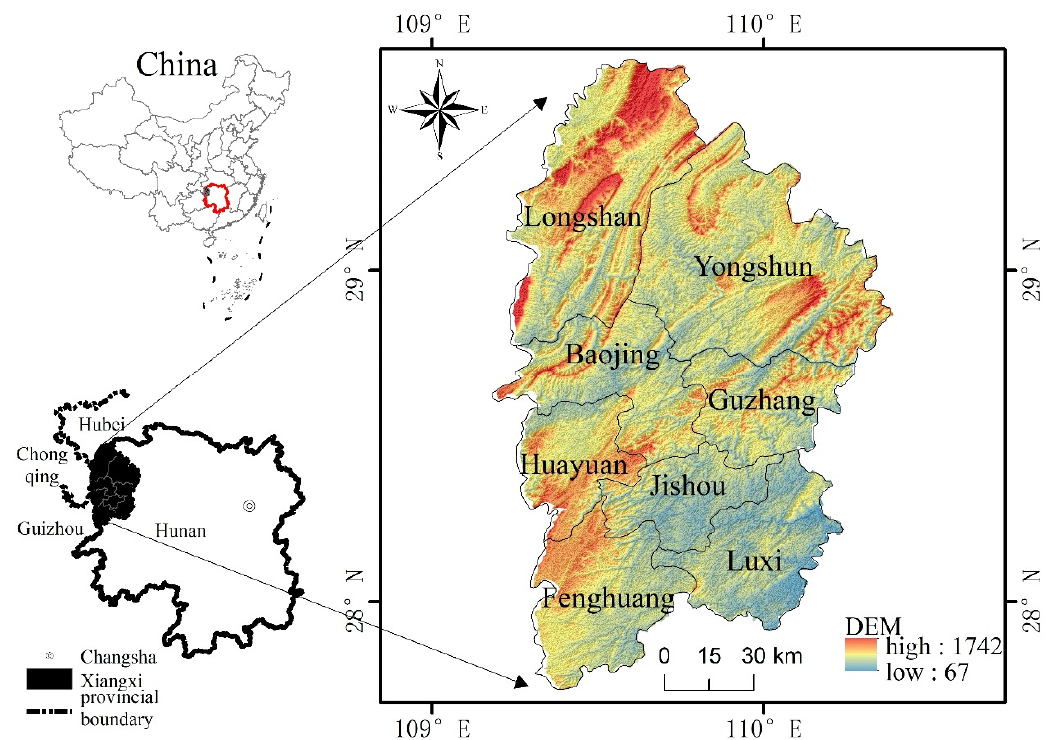
Figure 1. Location of the study area.